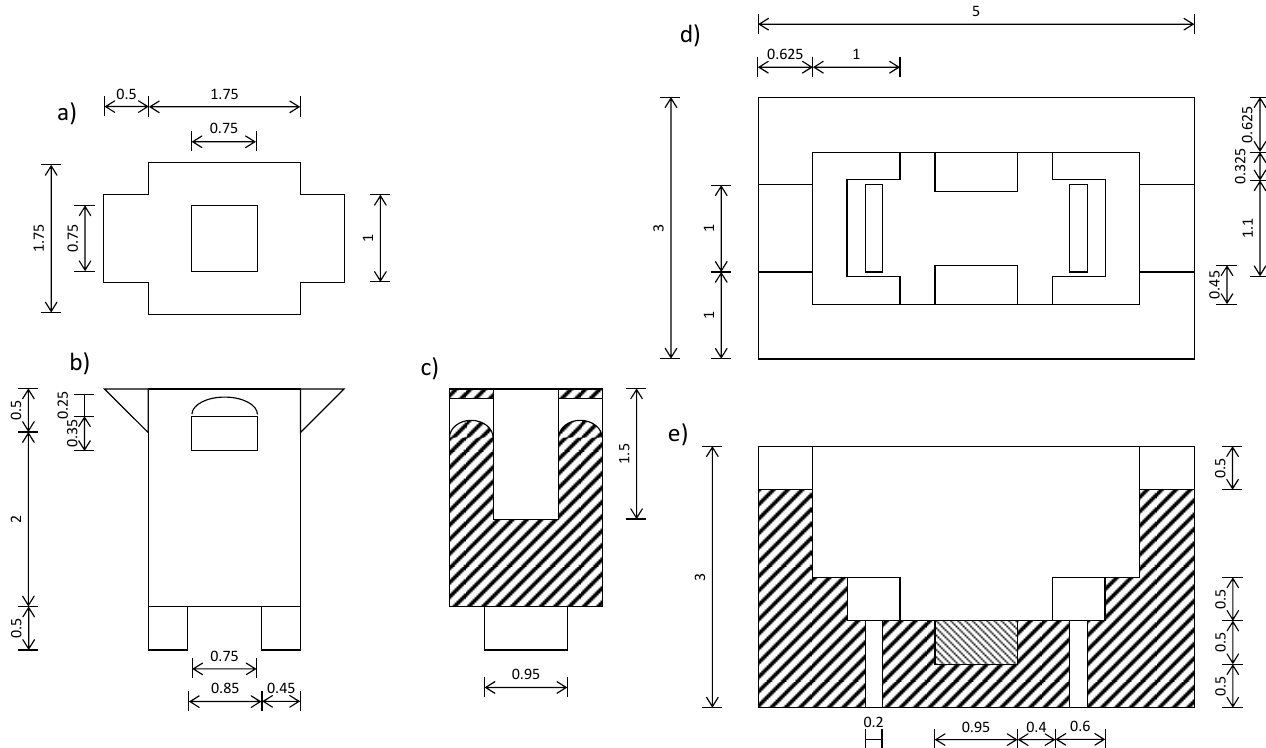
Figure 4. ( a ) Plan view of the measuring tank; ( b ) Elevation view of the measuring tank; ( c ) Cross-section section of the measuring tank; ( d ) Plan view of the outer shell; ( e ) Cross-section of the measuring tank. The dimensions of the whole figure are in centimeters.